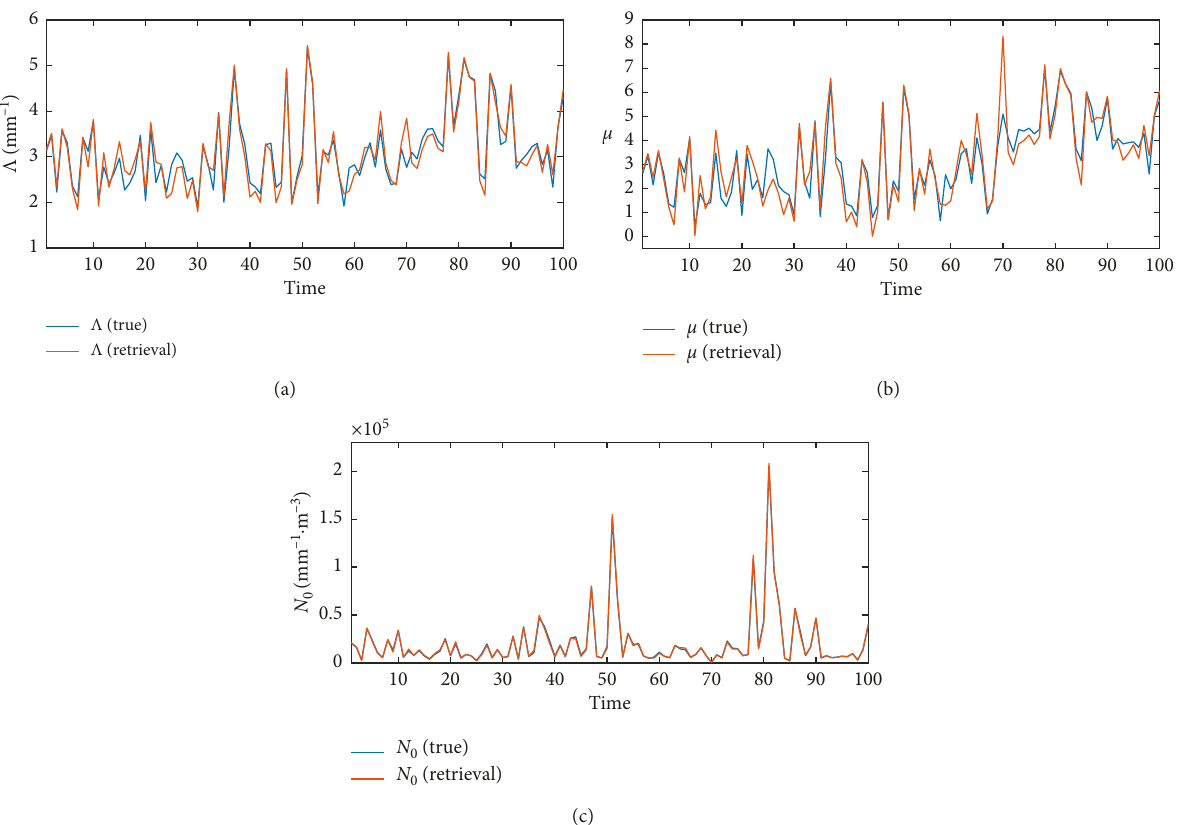
Figure 6: Retrieval results of the DSD parameters (second group): the retrieval values with and without noise are distributed near the true values in all three DSD